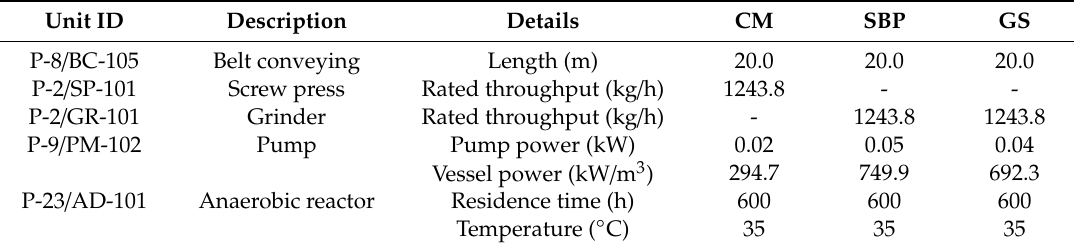
Figure 2. Process flow diagram of the biogas production in SuperPRO Designer. Table 2. Main parameters that are used in the simulation of anaerobic digestion of CM, SBP, and GS.